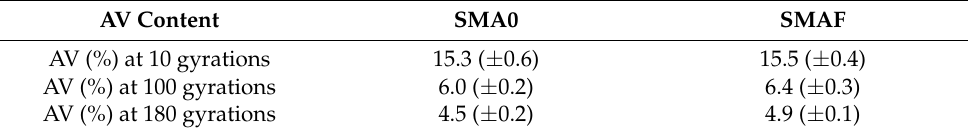
Table 5. Average AV content for SGC samples.